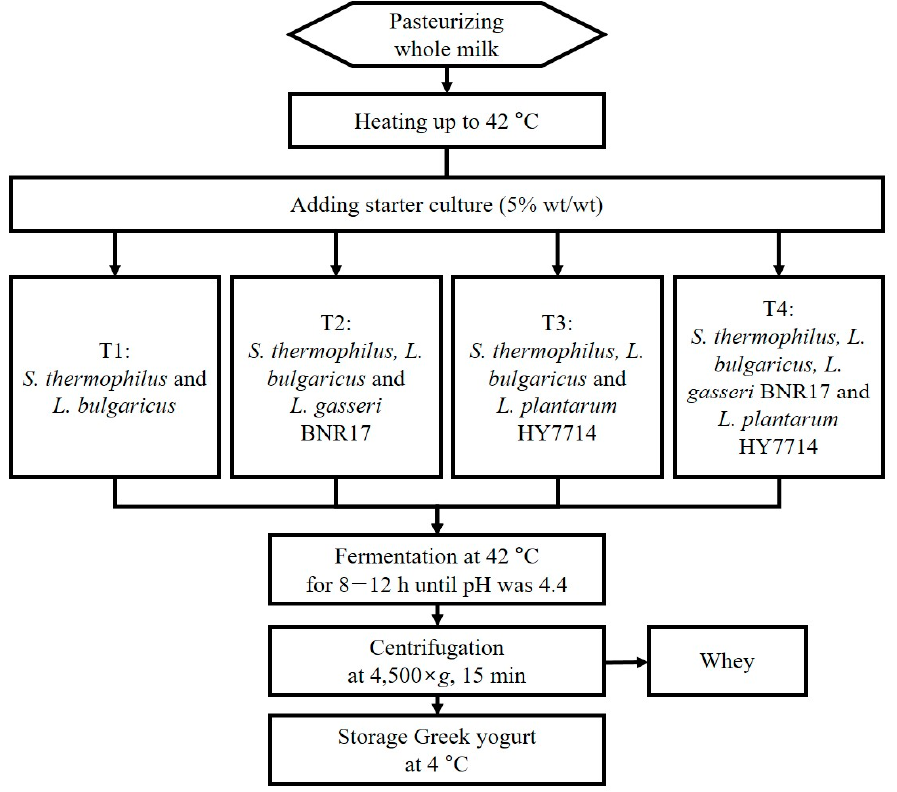
Figure 1. Flow chart of the manufacturing of Greek yogurt with four types of starter culture.